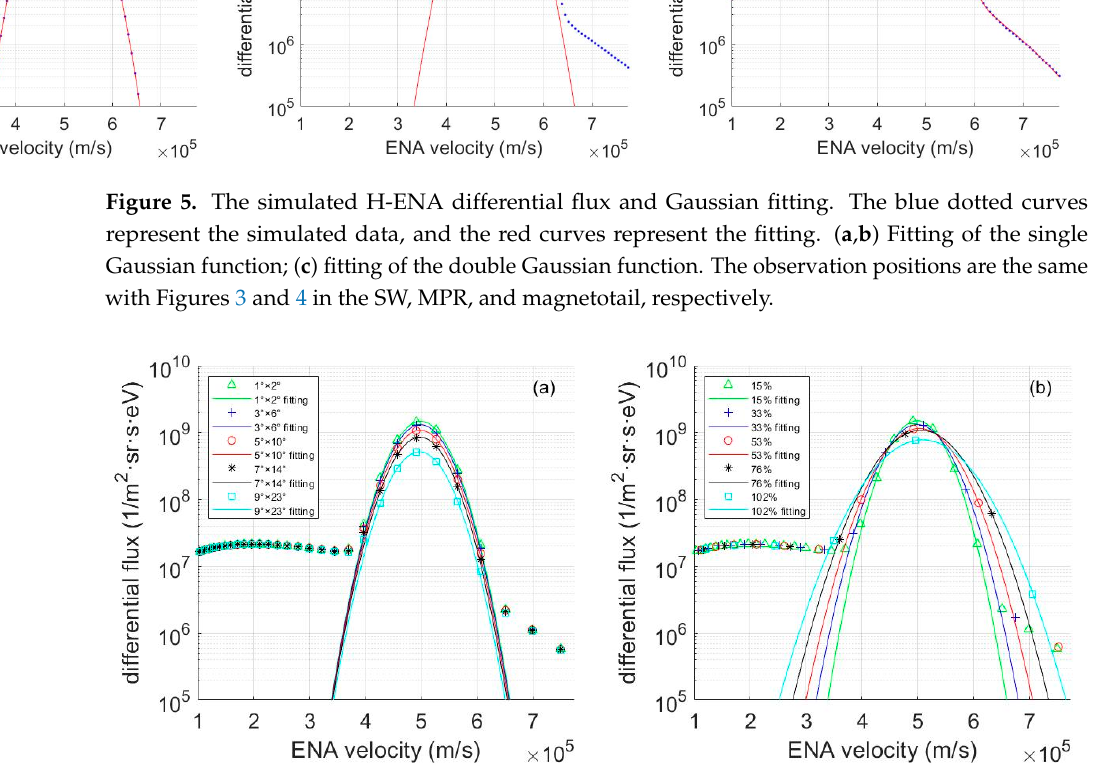
Figure 6. The simulated H-ENA di ff erential fl ux observed with ( a ) di ff erent angular resolutions; ( b ) di ff erent energy resolutions.